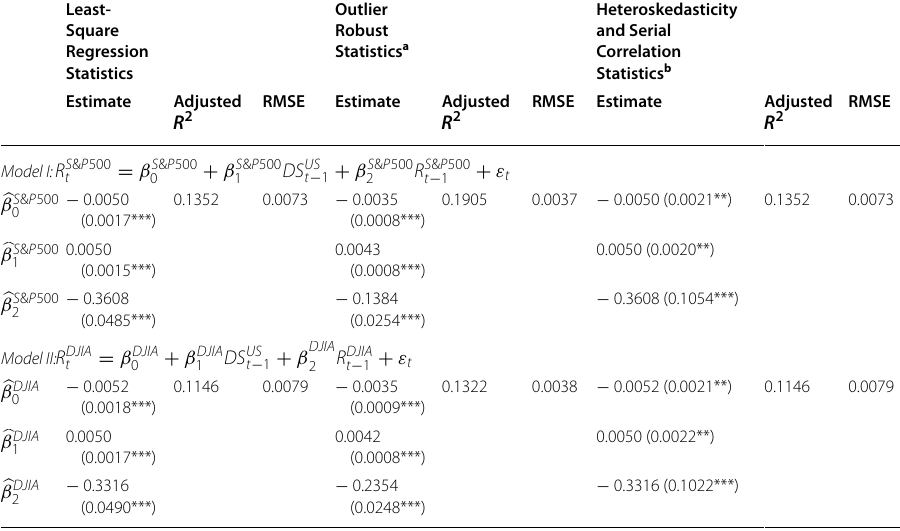
Table 4 Estimation Results of Stepwise Predictive Regression Models and Robustness of Parameter Estimates: